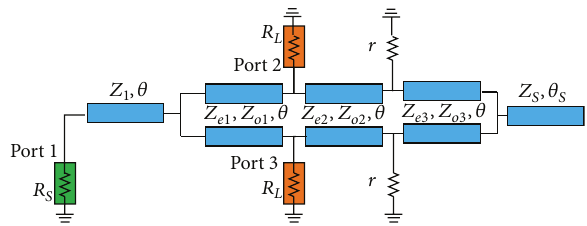
Figure 1: The circuit configuration of the proposed impedance- transforming dual-band coupled-line Gysel power